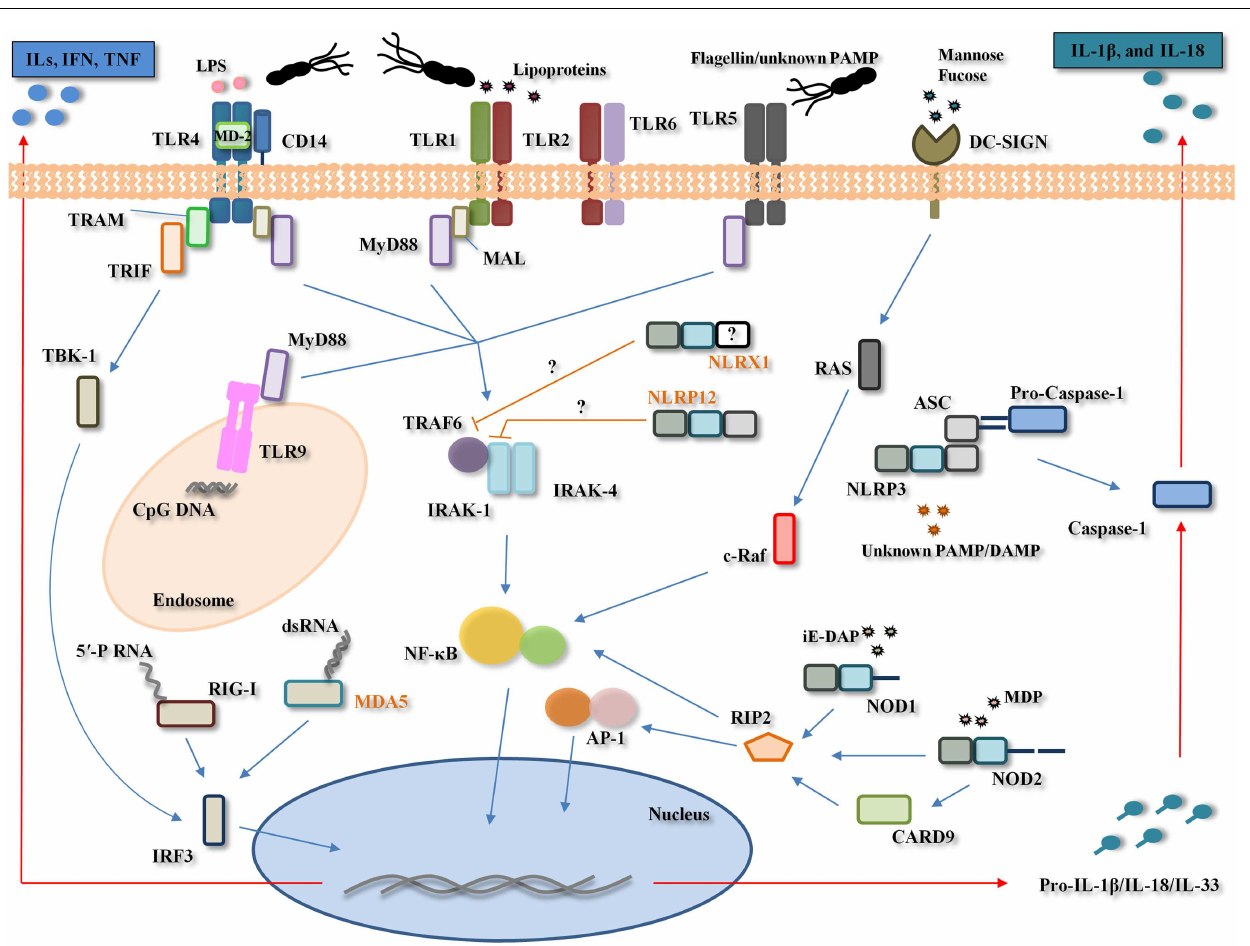
FIGURE 2 | Pattern-recognition receptors involvement in Helicobacter pylori infection . H. pylori is recognized by theToll-like receptors (TLRs) (TLR2,TLR4,TLR5, andTLR9), NOD-like receptors (NLRs) (NOD1, NOD2, NLRP3, and possibly, NLRP12 and NLRX1), RIG-I like receptors (RLRs) (RIG-I and possibly, MDA-5), and C-type lectin receptors (CLRs) (DC-SIGN).TLR4 poorly recognizes H. pylori lipopolysaccharide (LPS) to generate pro-inflammatory cytokines (e.g., IL-1 α , IL-1 β , IL-6, IL-8, IL-10, andTNF- α ) and interferons (IFNs) through the myeloid differentiation primary response gene 88 (MyD88)-dependent and -independent pathways, respectively.TLR2 recognizes H. pylori LPS/peptigoglycan/unknown pathogen-associated molecular pattern (PAMP) whileTLR5 poorly recognizes H. pylori flagella and TLR9 recognizes H. pylori DNA (unmethylated CpG motifs). H. pylori recognition by these threeTLRs leads to nuclear factor- κ B (NF- κ B) activation. NOD1 and NOD2 recognize H. pylori peptidoglycan-derived